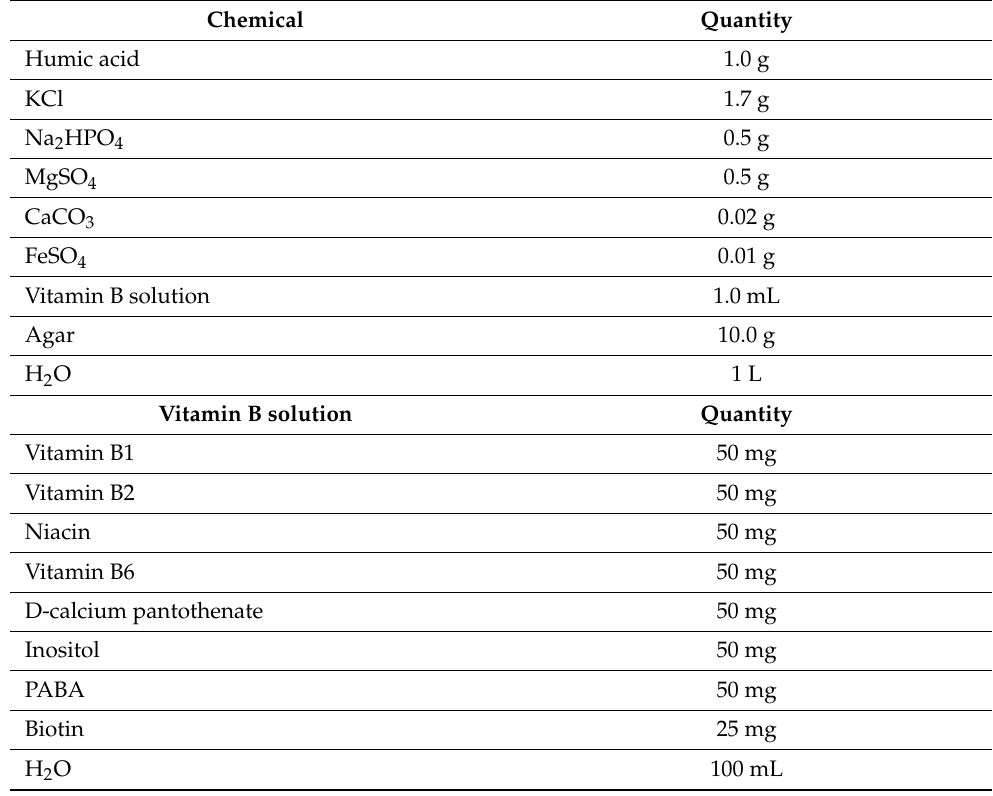
Table 1. Humic acid agar plates and Vitamin B solution (VB)